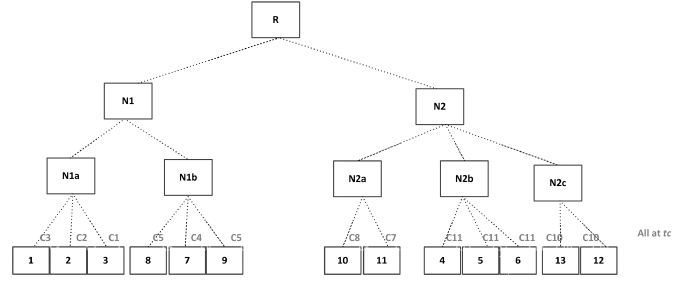
Figure 5. An example of the Moving Objects Timestamping-tree